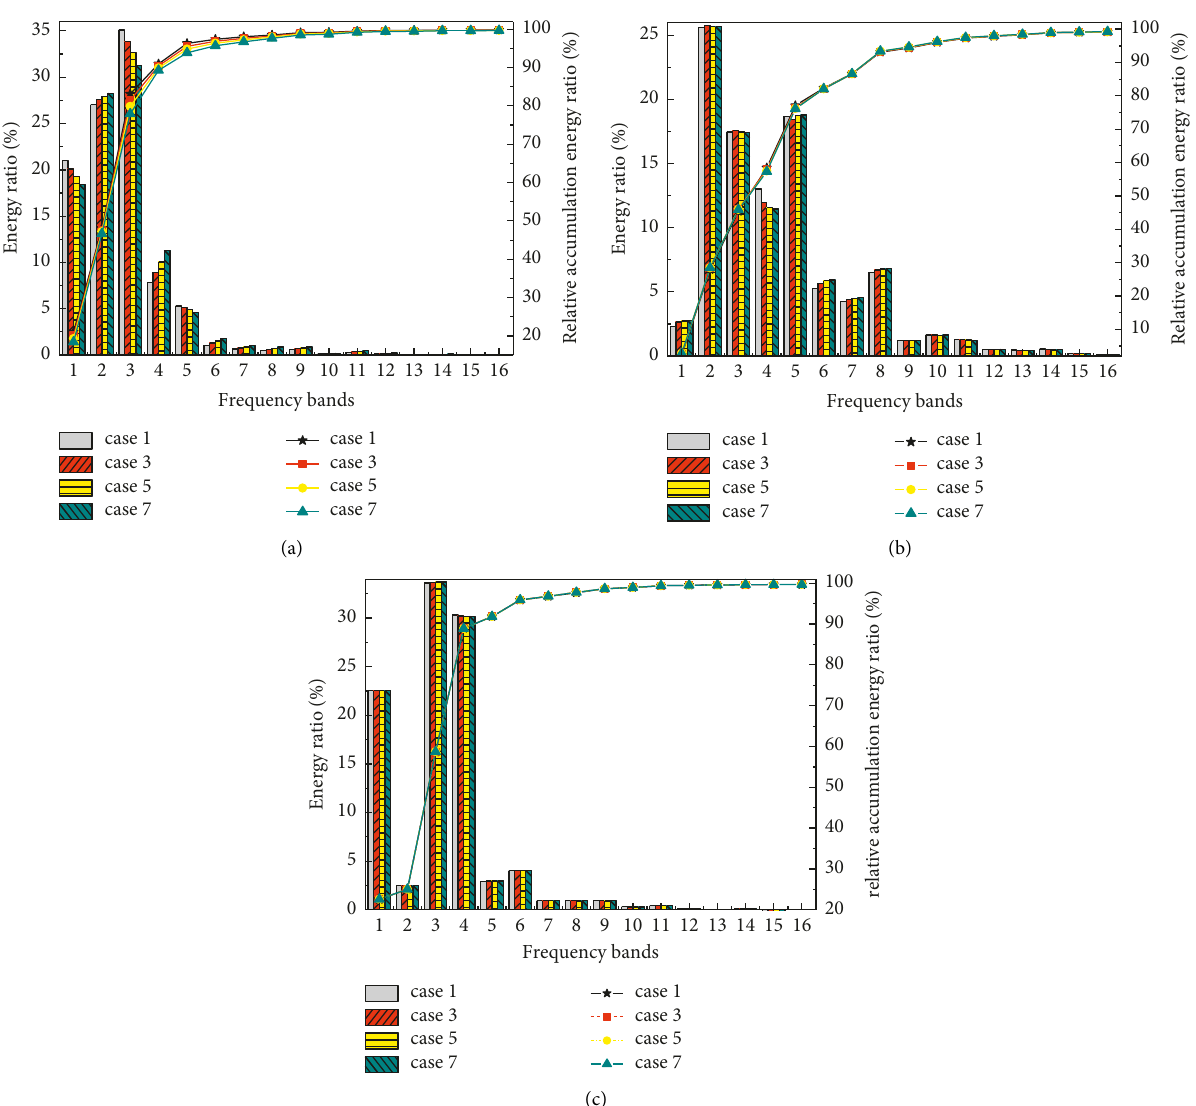
Figure 6: The frequency-ordered Wavelet Packet frequency bands energy ratio spectrum of different measurement points (the second time test at excitation point II). (a) Point 4. (b) Point 5. (c) Point